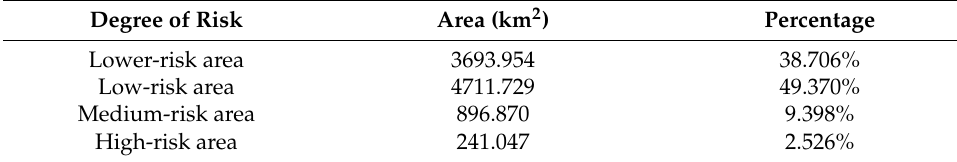
Figure 13. Landslide risk assessment zoning map in Xianyang City. Table 11. Area and proportion of each risk area.